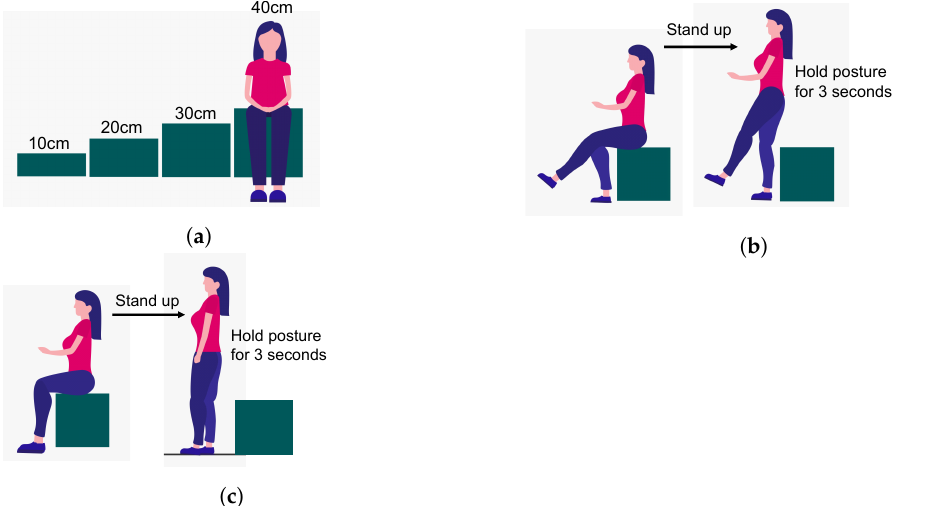
Figure 3. Details of the stand-up test in the form of illustrations [7]. This test is helpful for assessing the subject’s leg strength. ( a ) Different seat heights (10 to 40 cm) used for the stand-up test. ( b ) Stand-up test with both legs on the ground. ( c ) Stand-up test with single leg on the ground.